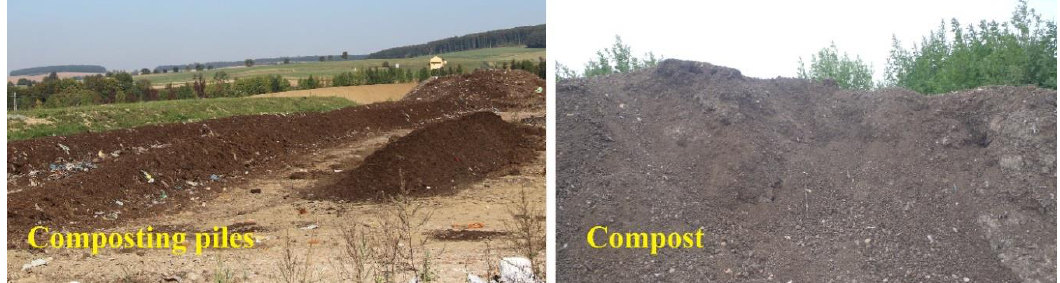
Figure 3. Composting piles located on the landfill surface and ready compost.